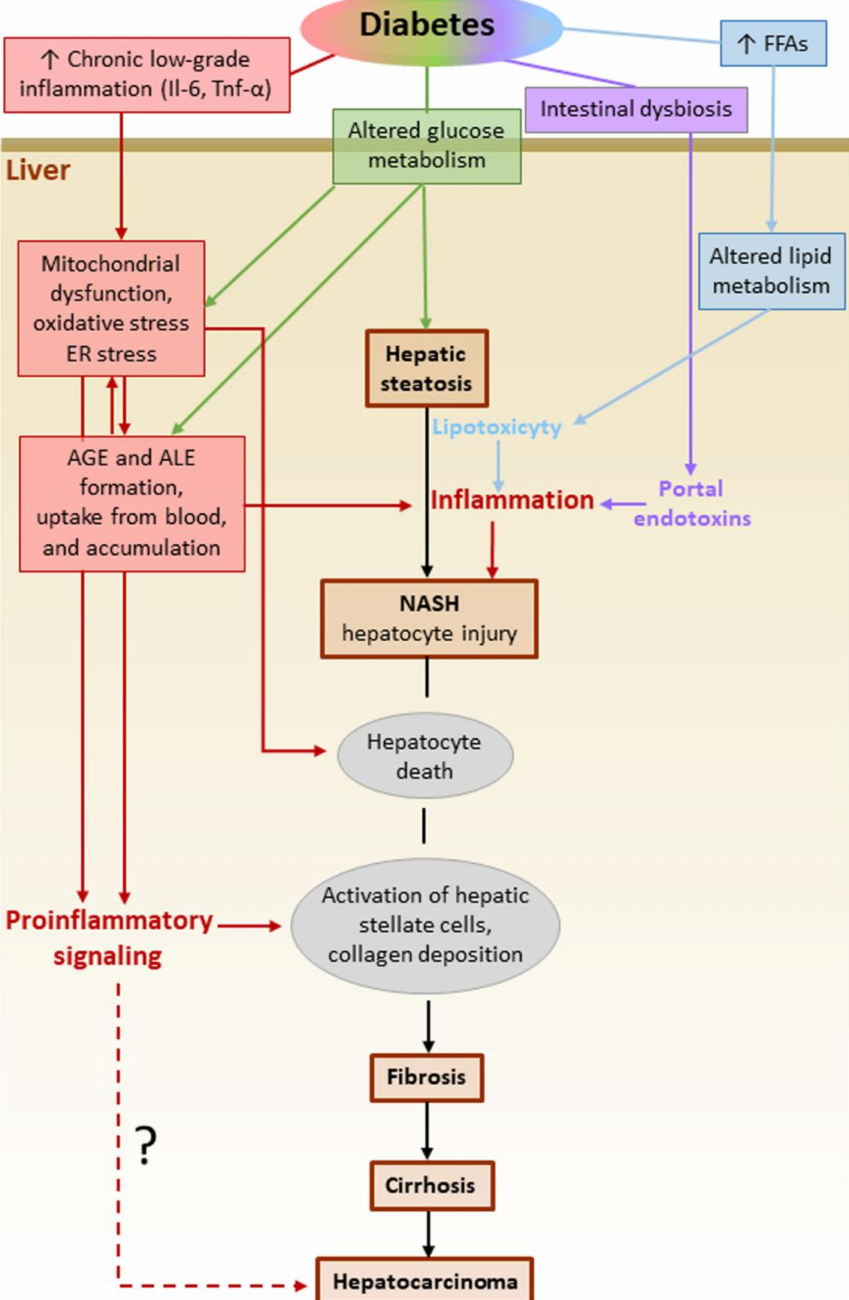
Figure 6. Molecular mechanisms underlying the accelerating e ff ect of diabetes mellitus on the initiation and progression of NAFLD. The dashed line indicates a hypothesis under investigation. IL-6 = interleukin-6; TNF- α = Tumor necrosis factor- α ; FFAs = free fatty acids; ER = endoplasmic reticulum; NASH = non-alcoholic steatohepatitis; AGE = advanced glycation endproducts; ALE = advanced lipoxidation